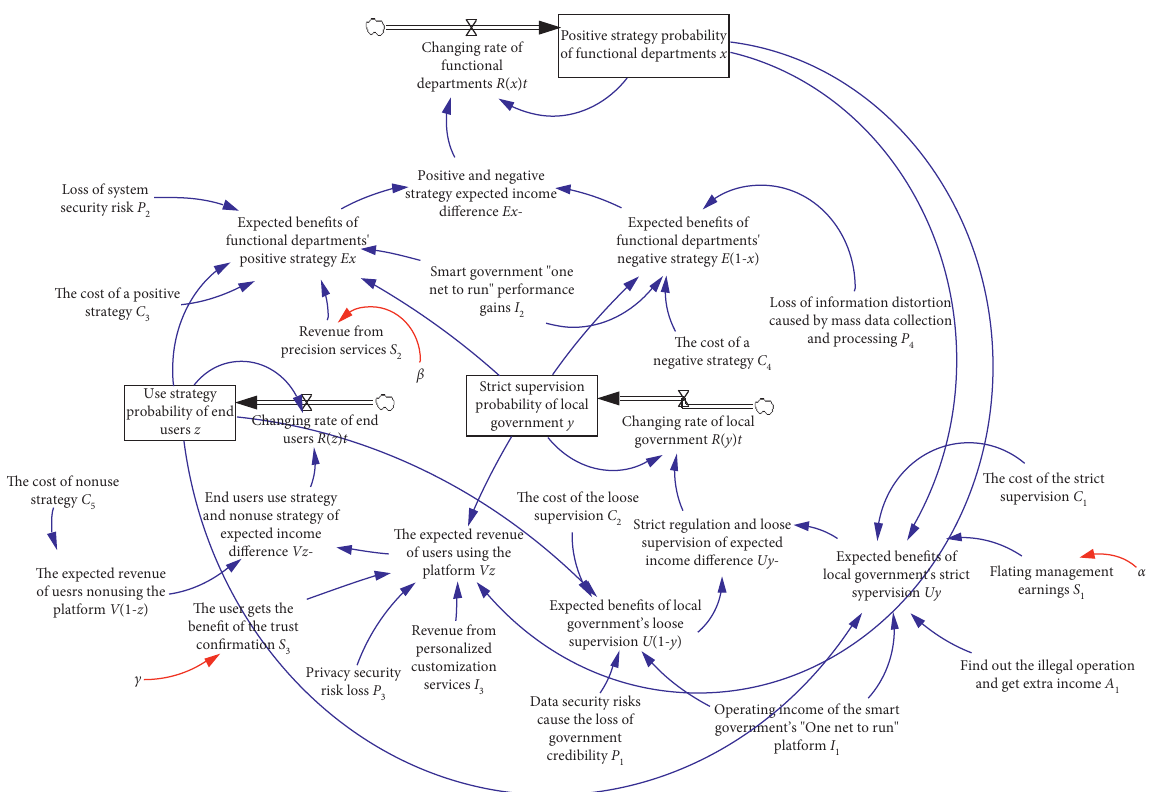
Figure 10: System dynamics (SD) model of functional department, local government, and end user evolutionary game